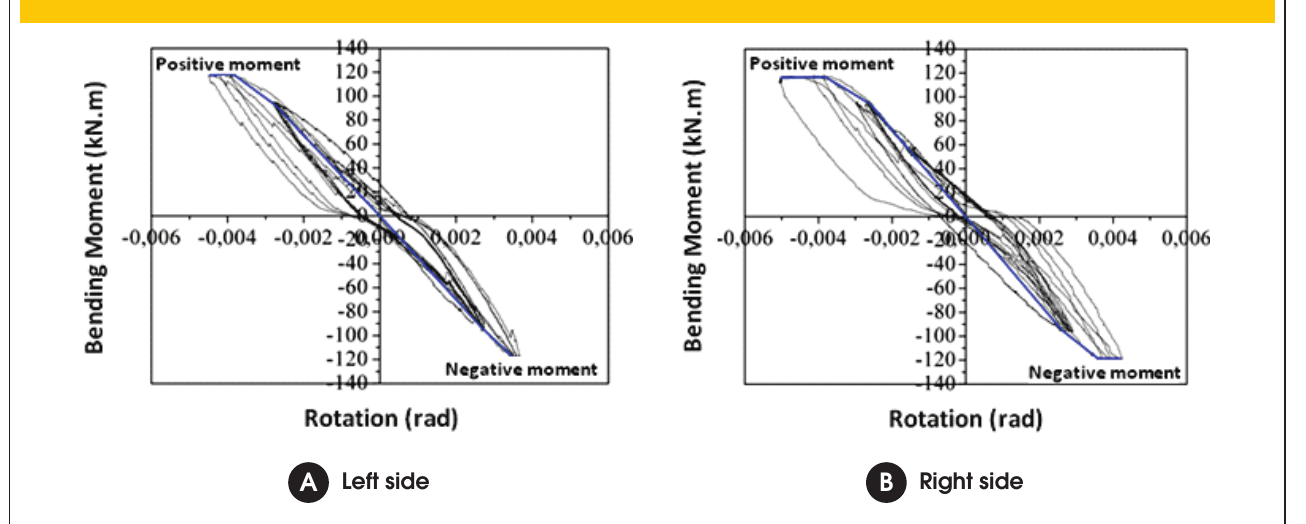
Figure 12 – Bending moment versus Rotation curves and envelope curves of Model